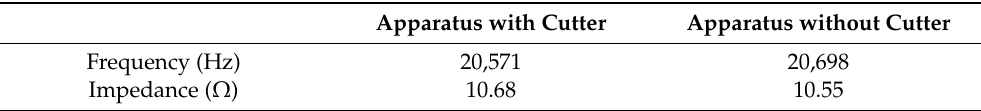
Table 2. Testing results for ultrasonic vibration